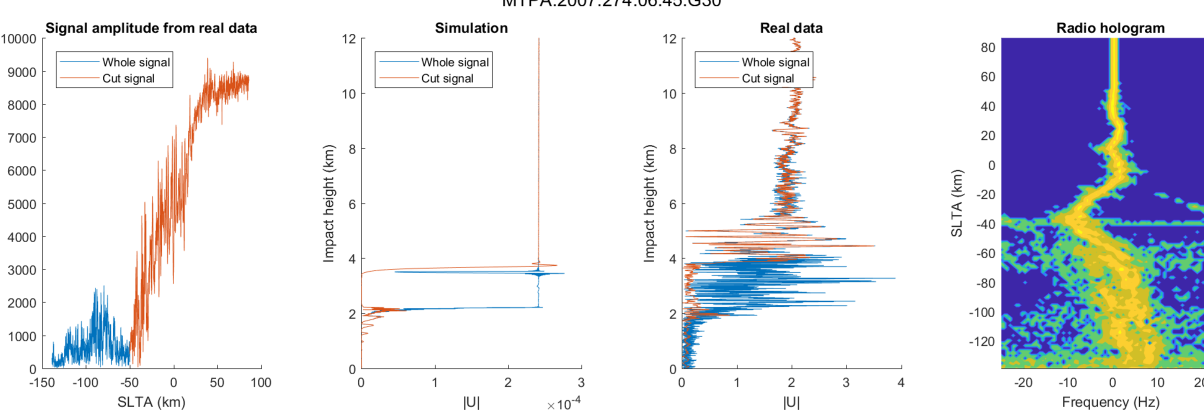
rect signal coincide around a min (approximately at 2 . 1